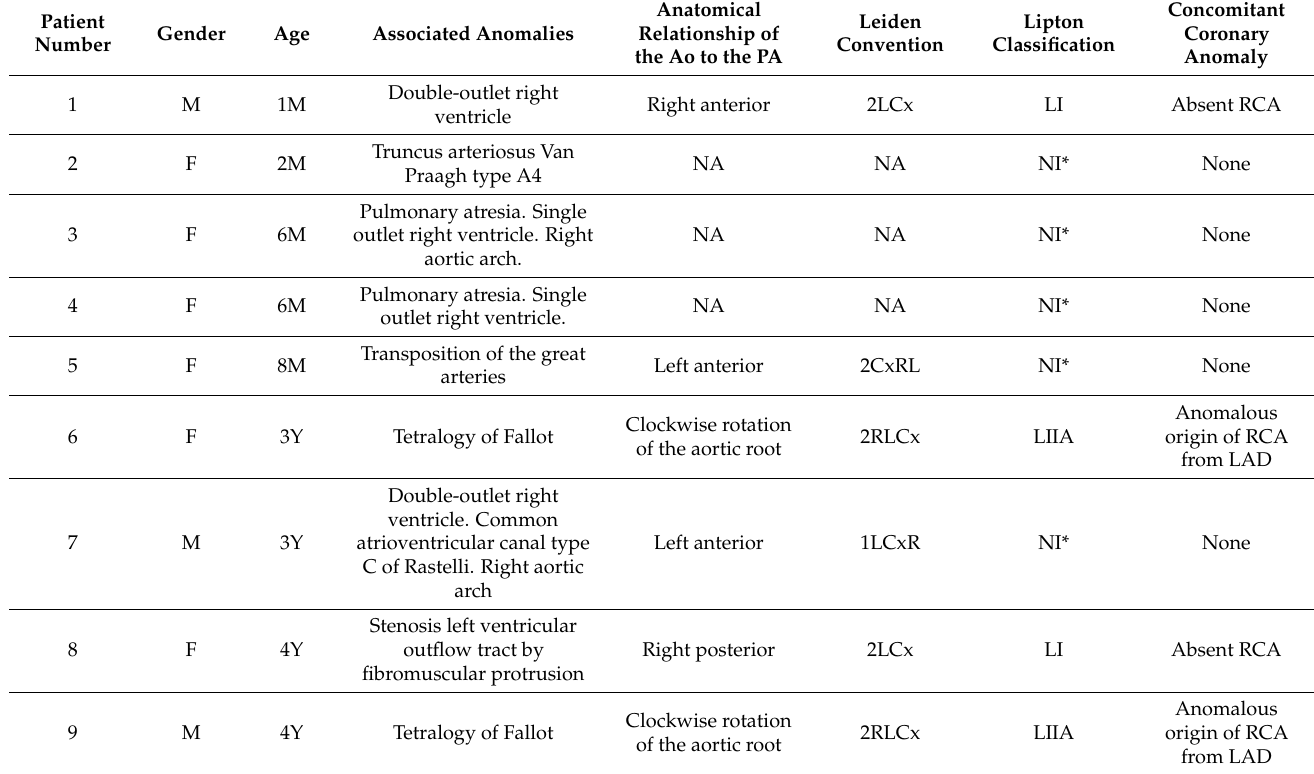
Table 1. Patients’ demographics, associated congenital heart disease, imaging Leiden Convention and Lipton classification. Patient